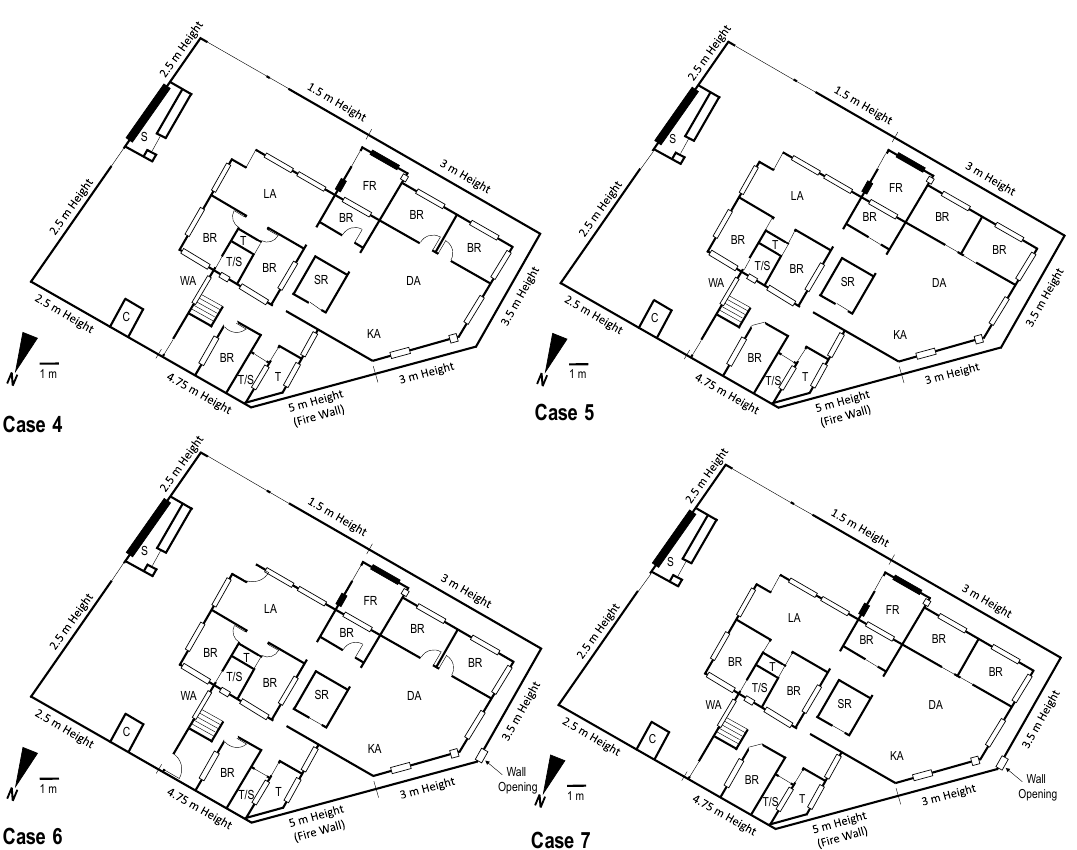
Figure 5. Simulation cases for the detached family house: Case ( 1 ) low lot perimeter wall (all windows